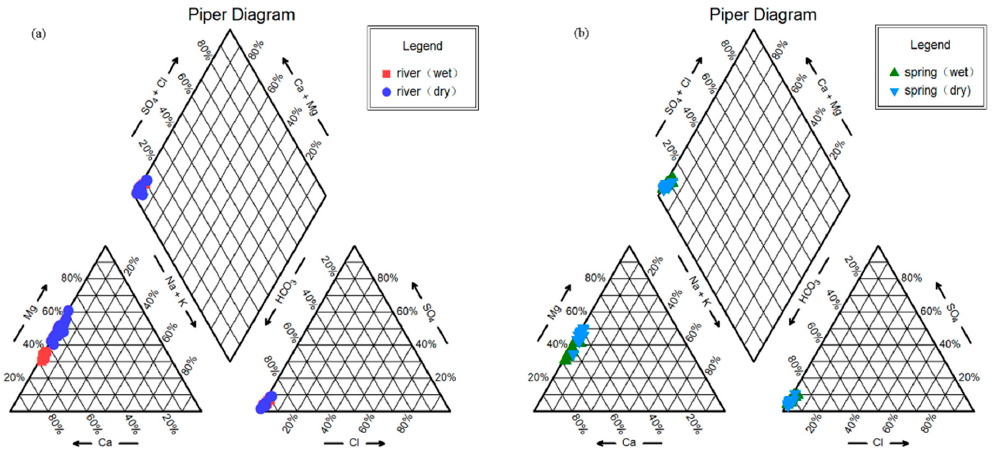
Figure 3. Chemistry Piper diagram of the river ( a ) and spring ( b ) water in the Huangzhouhe River Basin.